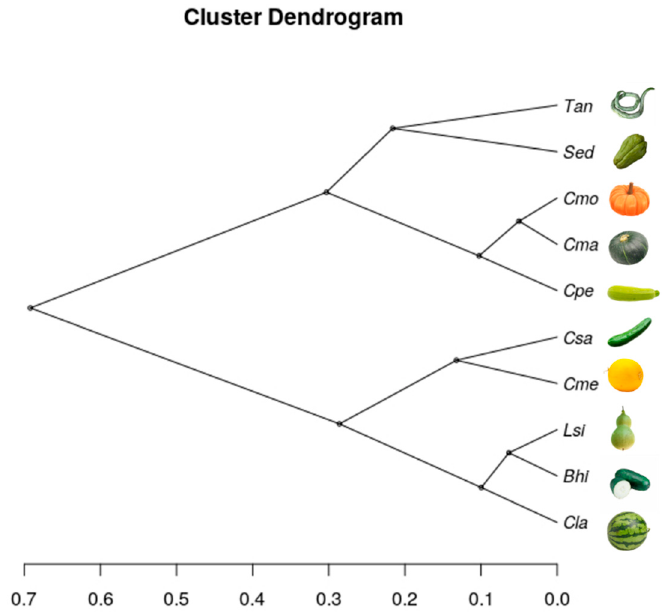
Figure 10. Cluster tree based on the RSCU values of ten species of Cucurbitaceae. Note: the horizontal axis represents the height of horizontal clustering. The cluster tree is calculated and drawn by the ggdendro package based on the R language.